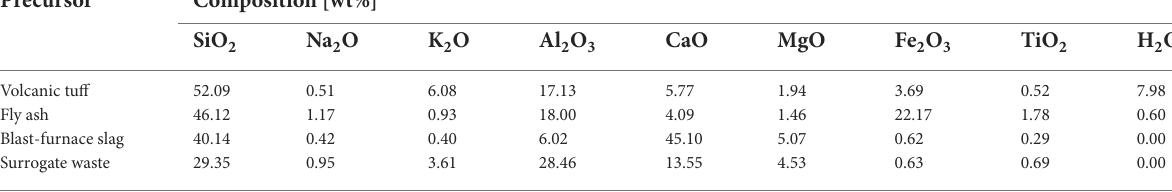
TABLE 1 Chemicalcompositionofthematerialsusedinthegeopolymericmatrices,asprovidedbythesuppliers. Precursor